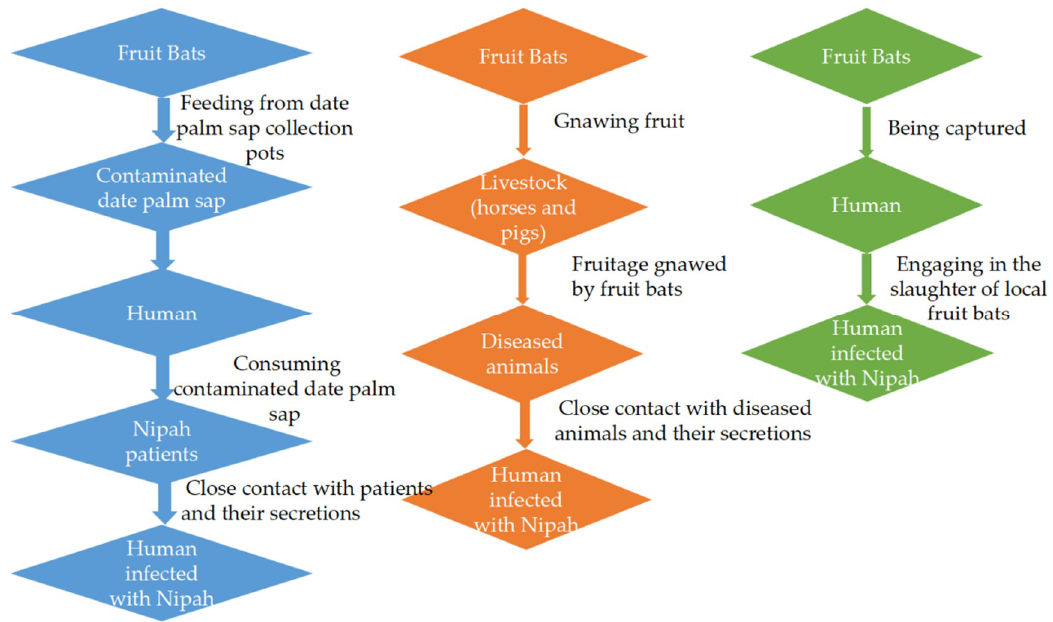
Figure 3. NiV’s transmission pathways in different countries. Blue: transmission routes in Bangladesh; orange: transmission routes in Malaysia and the Philippines; green: transmission routes in Africa and Cambodia .